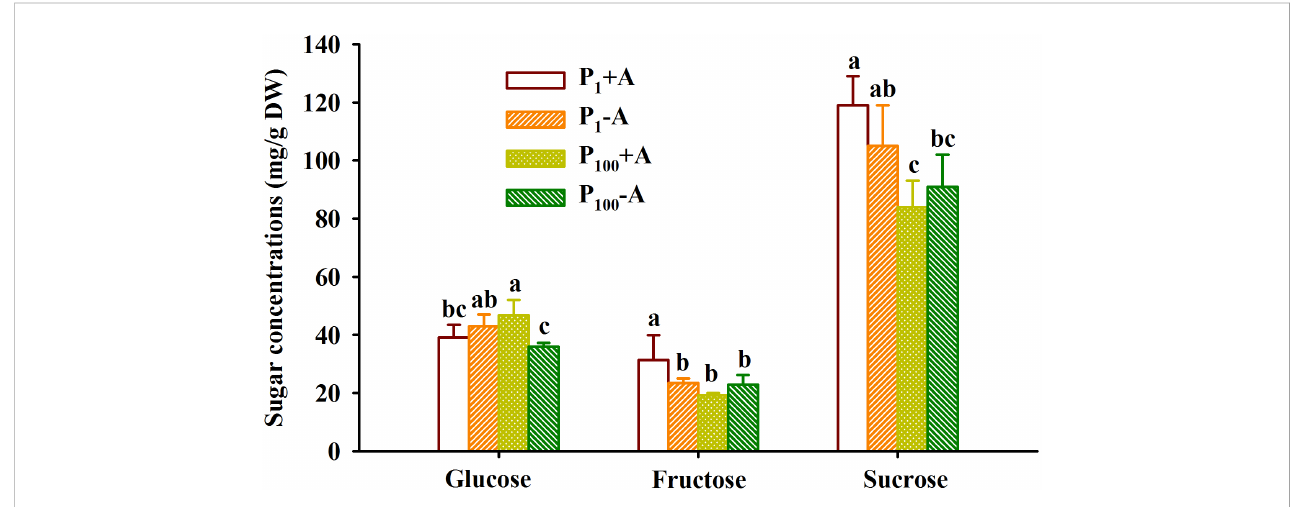
FIGURE 5 Changes in leaf fructose, glucose, and sucrose concentrations of walnut seedlings inoculated with Diversispora spurca grown in 1 and 100 m mol/L phosphorus levels. Data (means ± SD, n = 4) followed by different letters above the bars indicate signi fi cant ( P < 0.05) differences. The abbreviations were shown in Figure